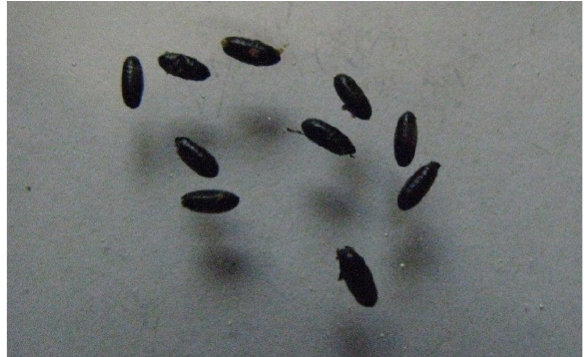
Fig. 10. Pupa of Acanthiophilus helianthi Rossi